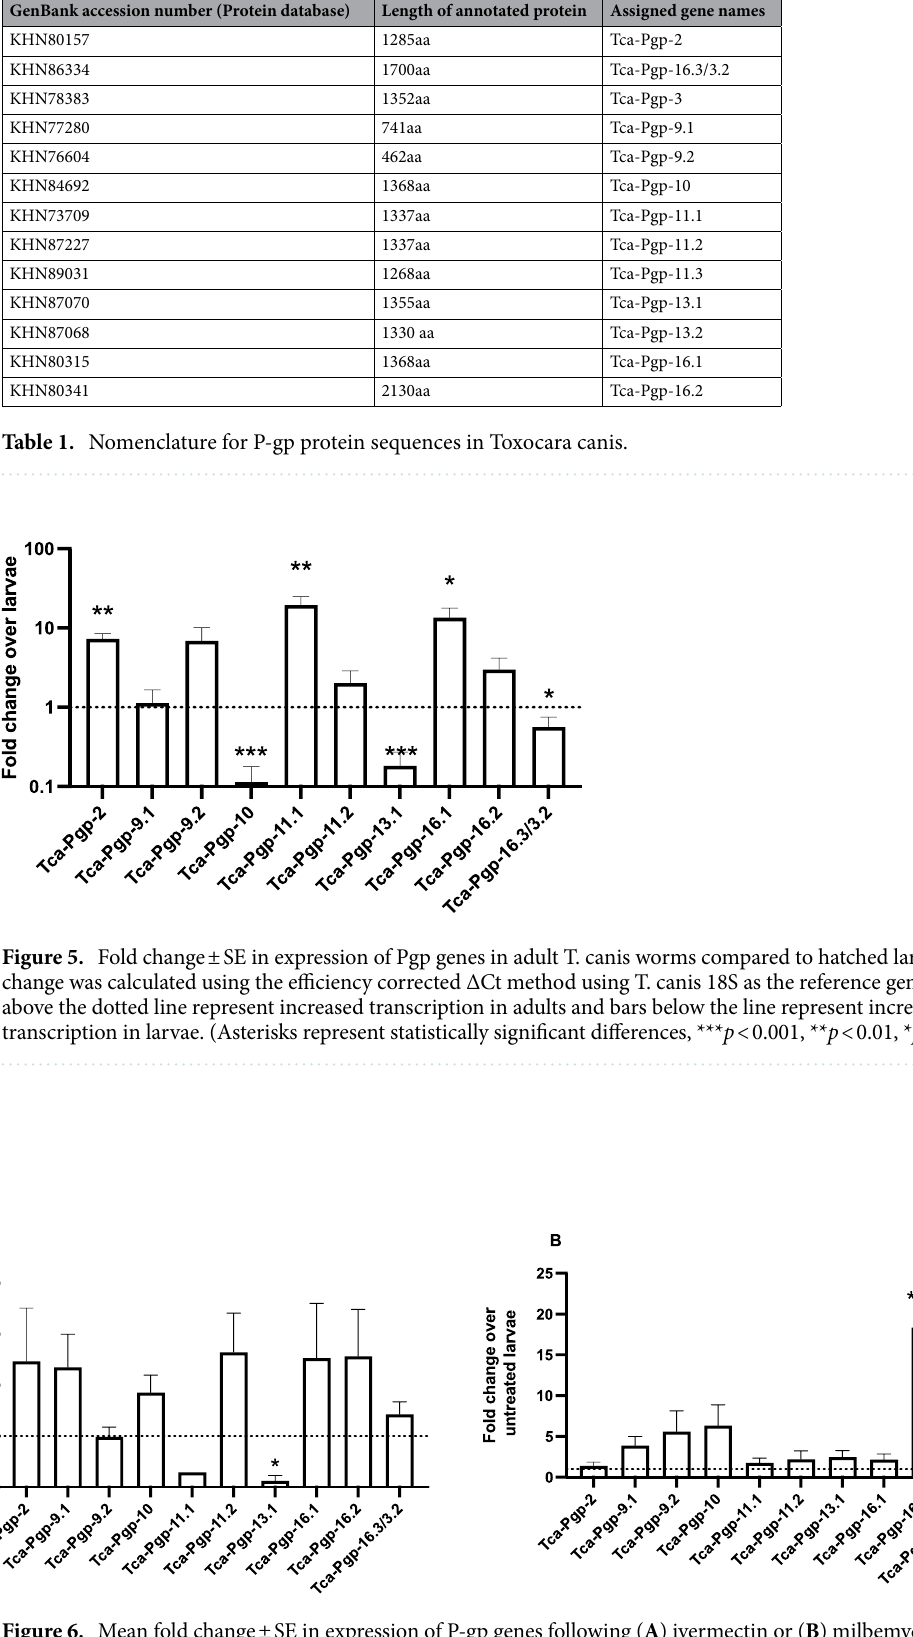
Figure 6. Mean fold change ± SE in expression of P-gp genes following ( A ) ivermectin or ( B ) milbemycin oxime treatment of larvae hatched in vitro. Fold change was obtained using the efficiency corrected ΔCt method using T. canis 18S as the reference gene. (Asterisk represents statistical difference from untreated controls **** p < < 0.0001, * p <